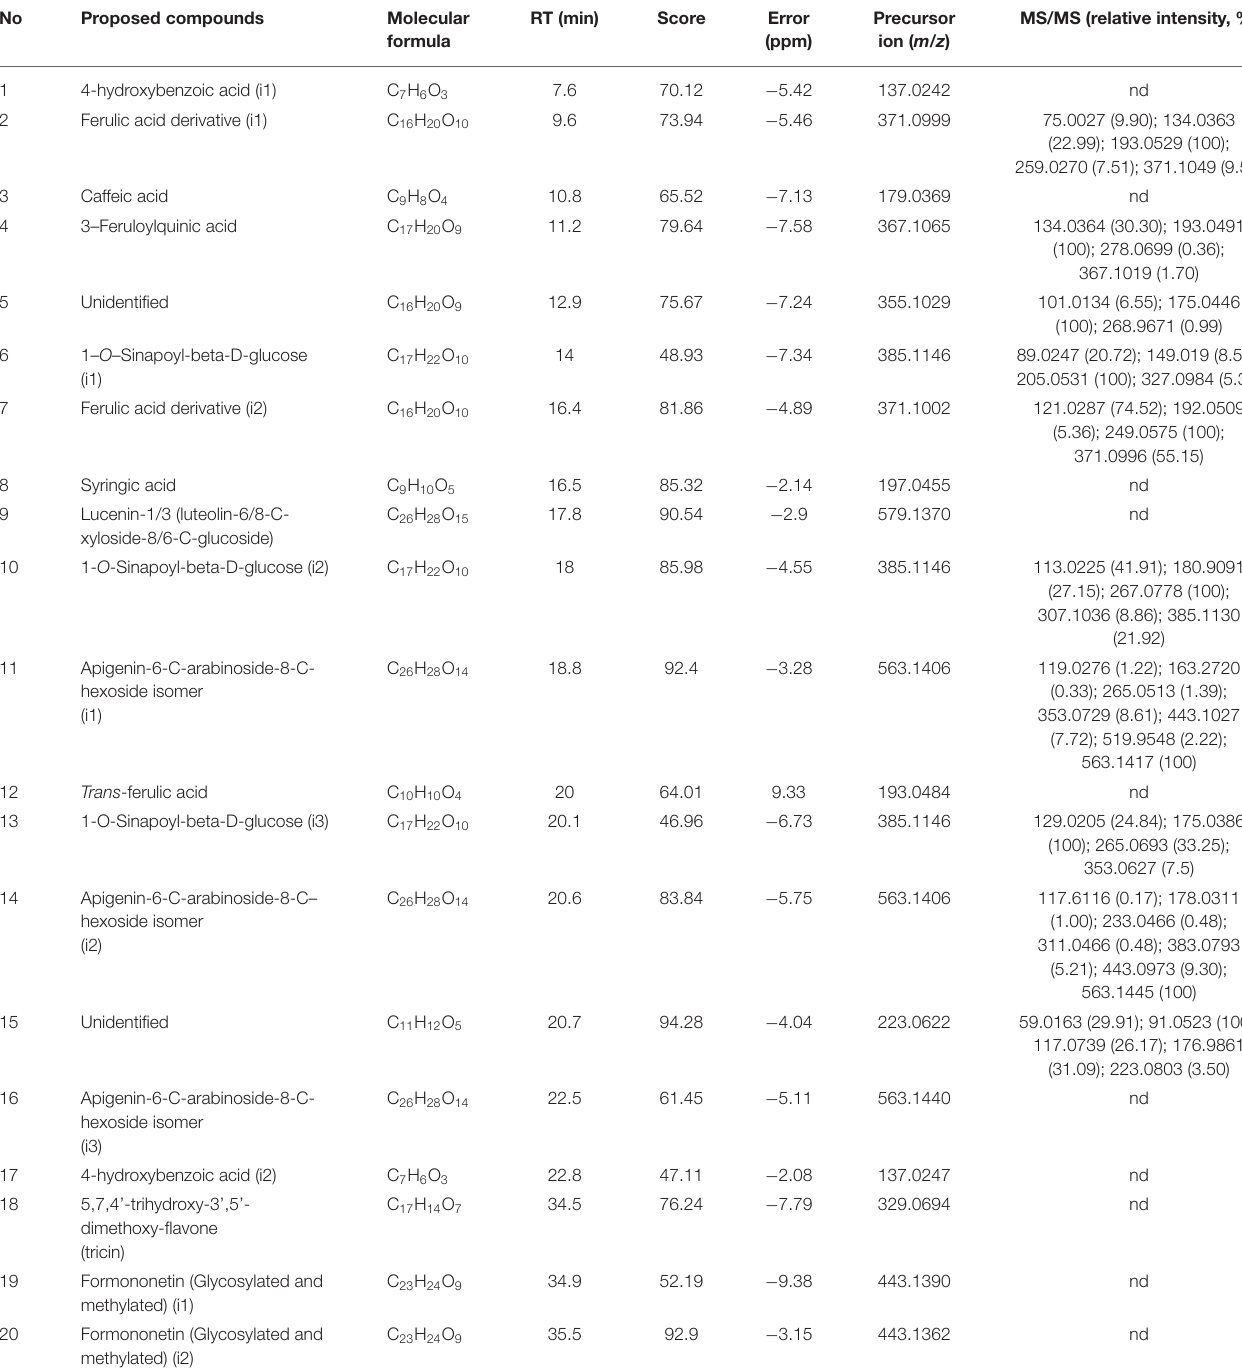
TABLE 2 | Tentative identification of GERM phenolic compounds by HPLC-ESI-QTOF-MS/MS in negative ion